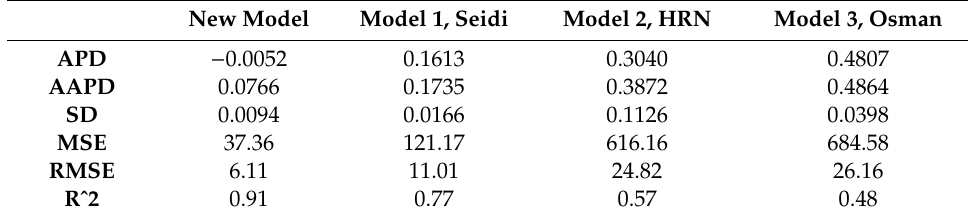
Table 8. A comparison of six di ff erent measures of accuracy corresponding to di ff erent models using the production data set of the 64 / 64 inch choke size.